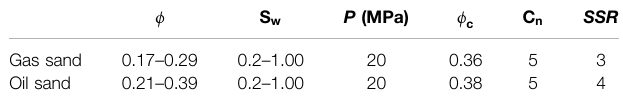
TABLE 1 | Rock physics model input values.